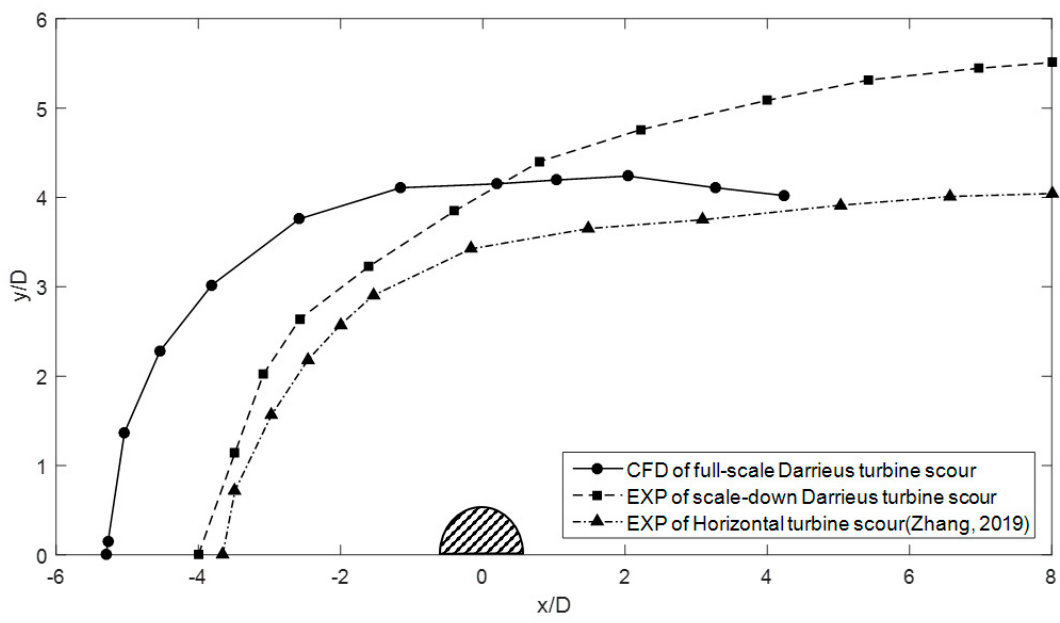
Figure 18. Half-plan view of scour hole edge around tidal current turbine’s foundation pile.